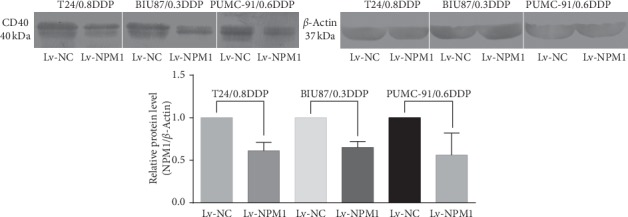
CD40 expression in the NPM1 silencing cisplatin-resistant bladder cell line and the negative control group.